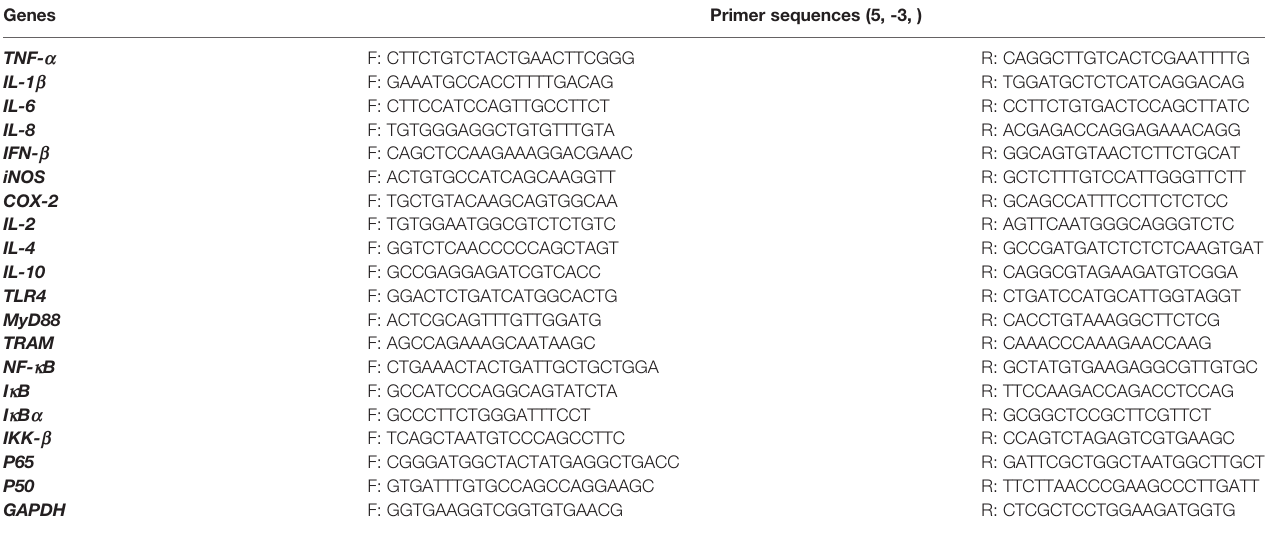
TABLE 2 | List of primers of the macrophage TLR4/MyD88/NF- k B pathway in qPCR analysis. Genes Primer sequences (5, -3, ) TNF-